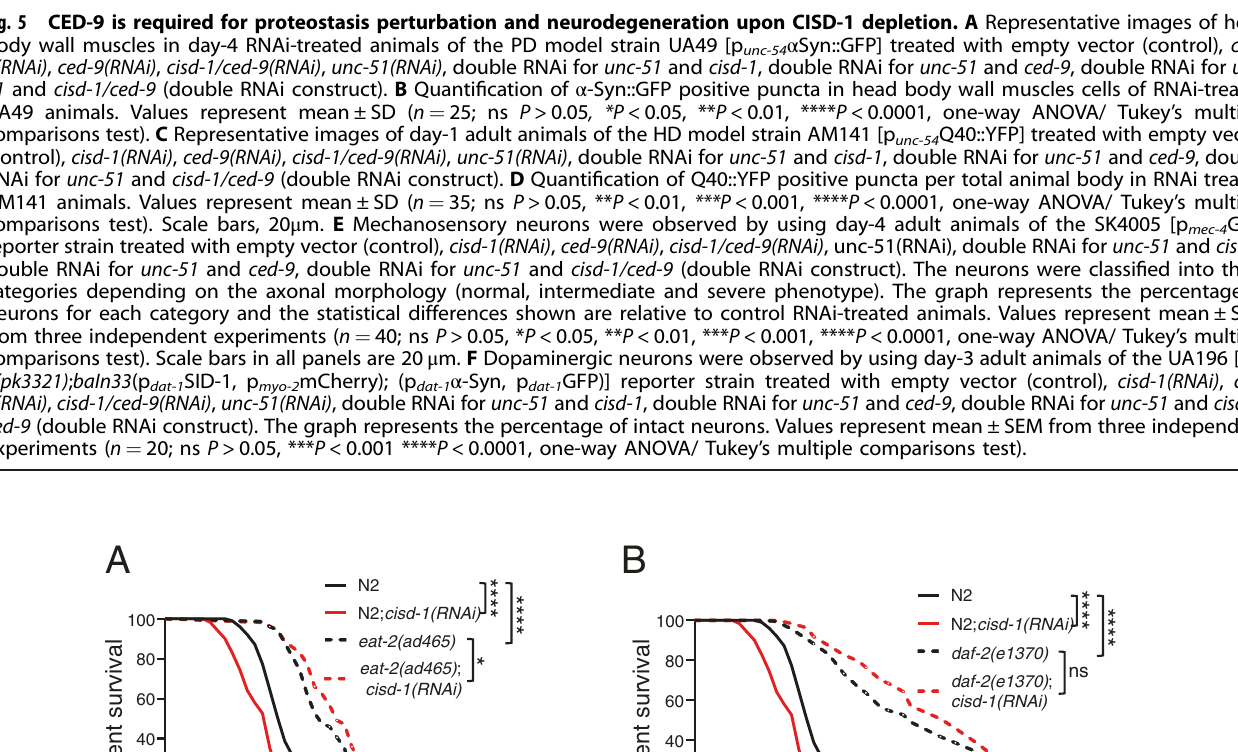
Fig. 6 Dietary restriction and low insulin signaling mitigate CISD-1 de fi ciency. A Survival curves of wt (normal solid lines) and eat-2(ad465) animals (dashed line) treated with empty vector (black) and cisd-1(RNAi) (red) from hatching (* P < 0.05, **** P < 0.0001, Log-rank/Mantel – Cox test). B Survival curves of wt (normal solid lines) and daf-2(e1370) animals (dashed line) treated with empty vector (black) and cisd-1(RNAi) (red) from hatching (ns P > 0.05, **** P < 0.0001, Log-rank/Mantel – Cox